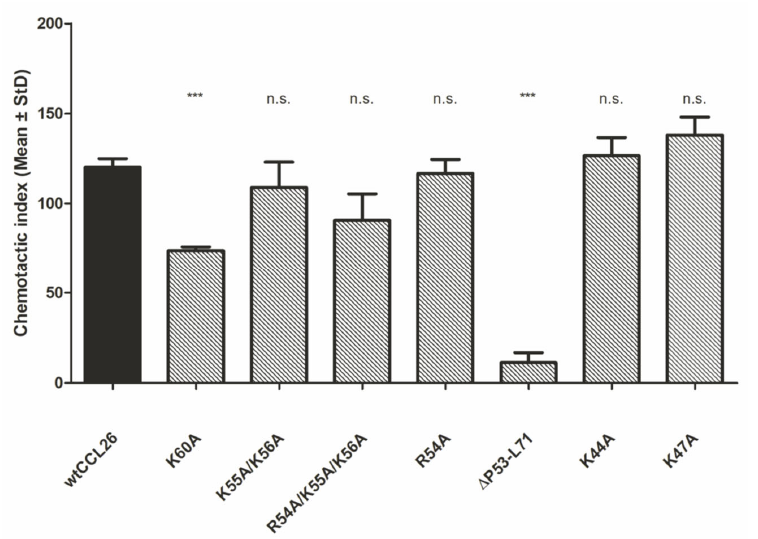
Figure 7. Results from Boyden chamber migratory assay of eosinophils towards 150 nM concentration of GAG ‐ binding knock ‐ out mutants of CCL26; *** p < 0.001 was considered statistically significant; n.s., non ‐ significant.